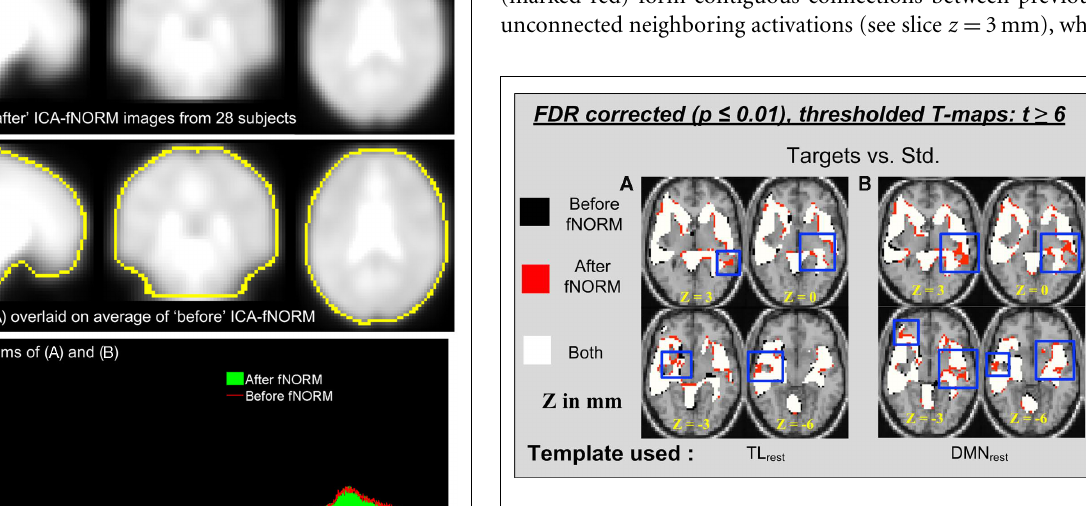
FIGURE 5 |Thresholded activation maps ( t > 6, p < 0.0001) for the target condition from the GLM analysis ( n = 28) showing overlapping and differential regions obtained “before” and “after” ICA-fNORM of AOD data done using different templates: (A)TL rest , (B) DMN rest . Each method is indicated using different colors: (i) red – “after” ICA-fNORM; (ii) black – “before” ICA-fNORM; and (iii) white – voxels active in both (1) and (2).The functional maps were overlaid on a re-sliced and co-registered anatomical template in